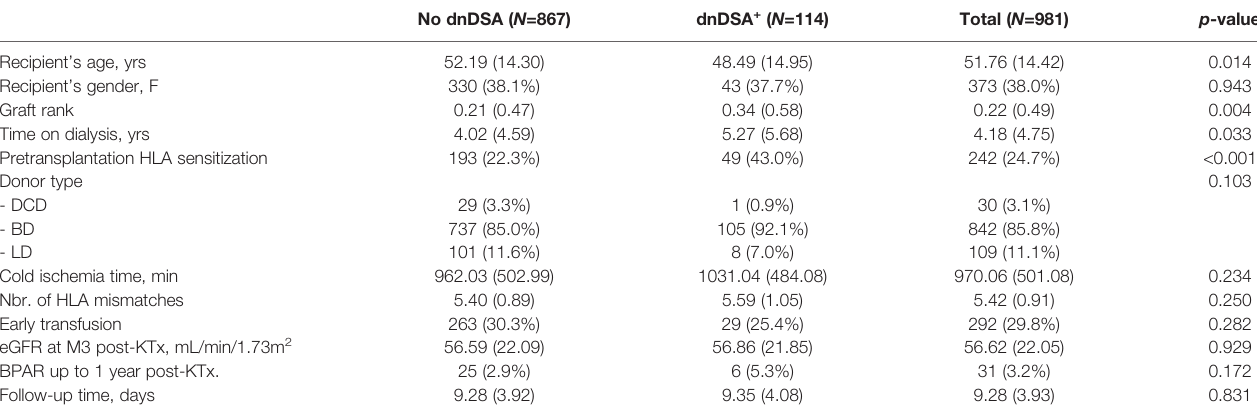
TABLE 3 | Description of the dnDSA - and dnDSA +